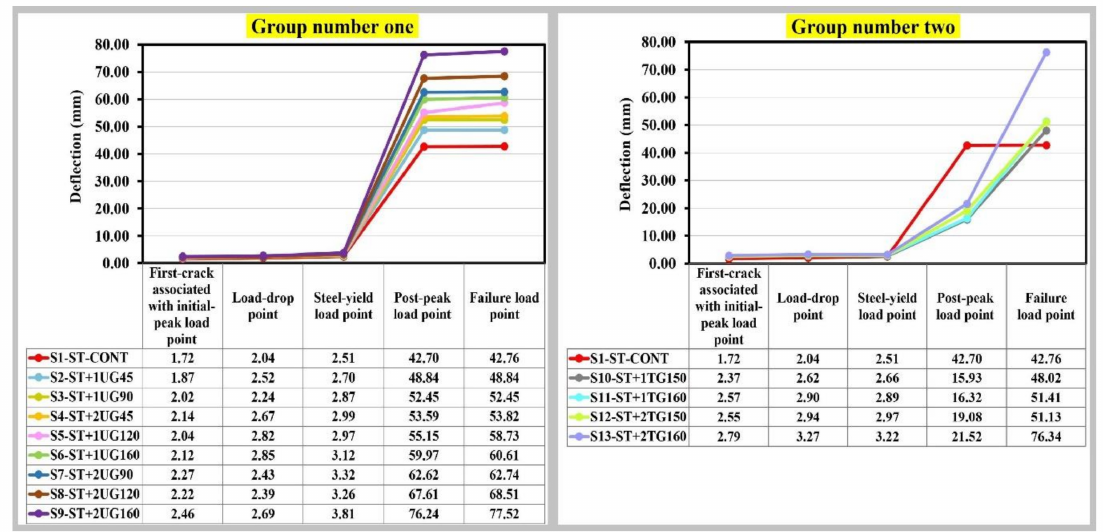
Figure 8. Concrete slabs deflection values at concrete slabs critical load points in comparison to the concrete control slab.